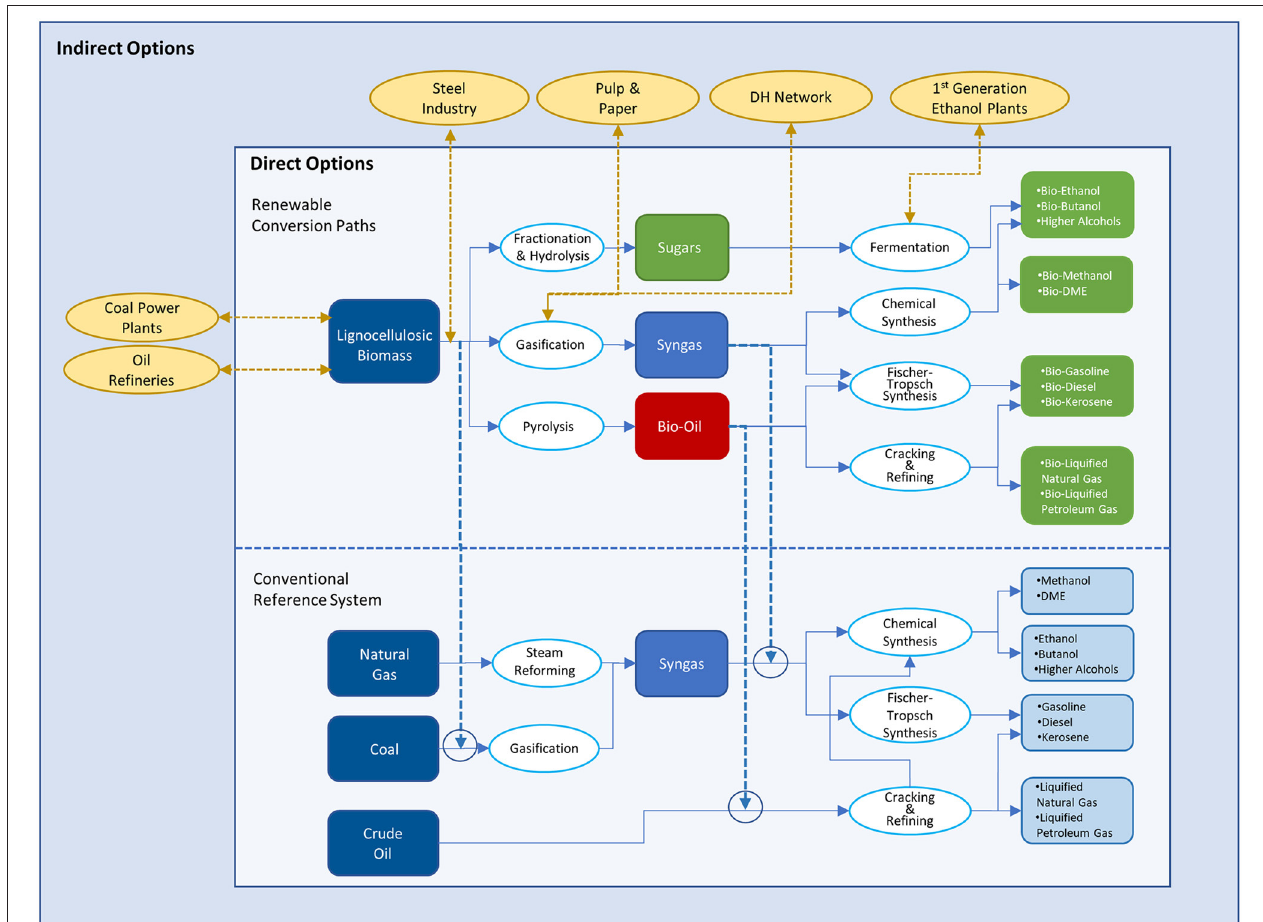
FIGURE 2 | Overview of different routes from biomass to fuel through various conversion technologies which refer to direct and indirect options.